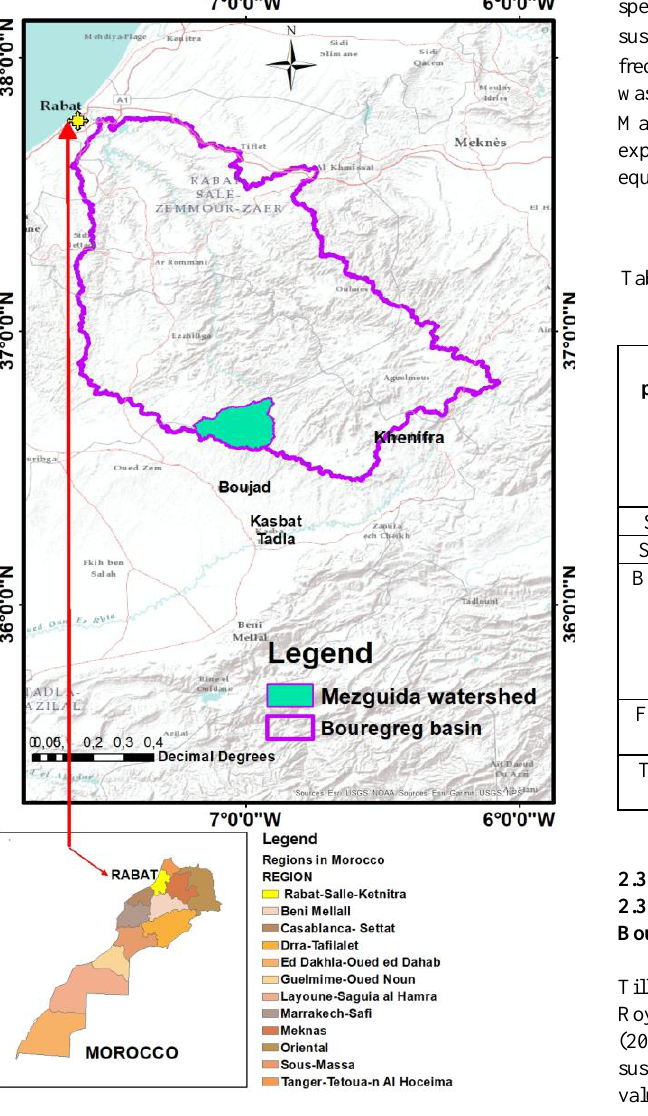
Figure 1. Study area location